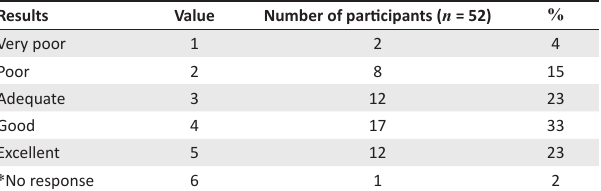
TABLE 4: Question 9b: Level of community participation in the drafting of the integrated development plans.